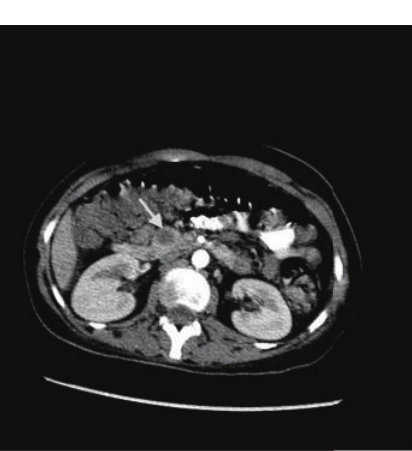
were performed with the initial diagnosis of insulinoma.